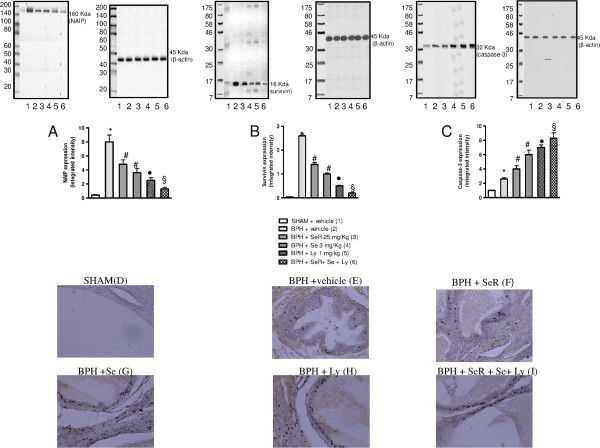
Expression of IAPs, NAIP, Survivin and caspase-3 in the Western Blot and Immunohistocehemical analysis.Top Panel: Representative Western Blot analysis of NAIP (A), survivin (B) and caspase-3 (C). The prostate is collected from Sham rats treated with vehicle and BPH rats treated with either vehicle or SeR (25 mg/Kg) or Se (3 mg/kg) or Ly (1 mg/kg) or Ser + Se + Ly *p < 0.01 vs Sham; #p < 0.05 vs BPH + vehicle; •p < 0.01 vs BPH + vehicle; §p < 0.001 vs BPH + vehicle. Bars represent the mean ± SEM of seven experiments. Bottom Panel: Immunhistochemical detection of Caspase-3. The prostate is collected from Sham rats treated with vehicle (D) and BPH rats treated with either vehicle (E) or SeR (25 mg/Kg) (F) or Se (3 mg/kg) (G) or Ly (1 mg/kg) (H) or SeR + Se + Ly (I). Immunohistochemistry for caspase-3 showed a negative reaction in sham (D). In BPH rats treated with vehicle (E), a focal cytoplasmatic positivity was documented in acini and stromal cells. A progressive enhancement of positivity was observed in BPH rats treated with SeR (F), Se (G), Ly and with the combination of SeR + Se + Ly (I), where it reached the highest expression. Original magnification ×400.